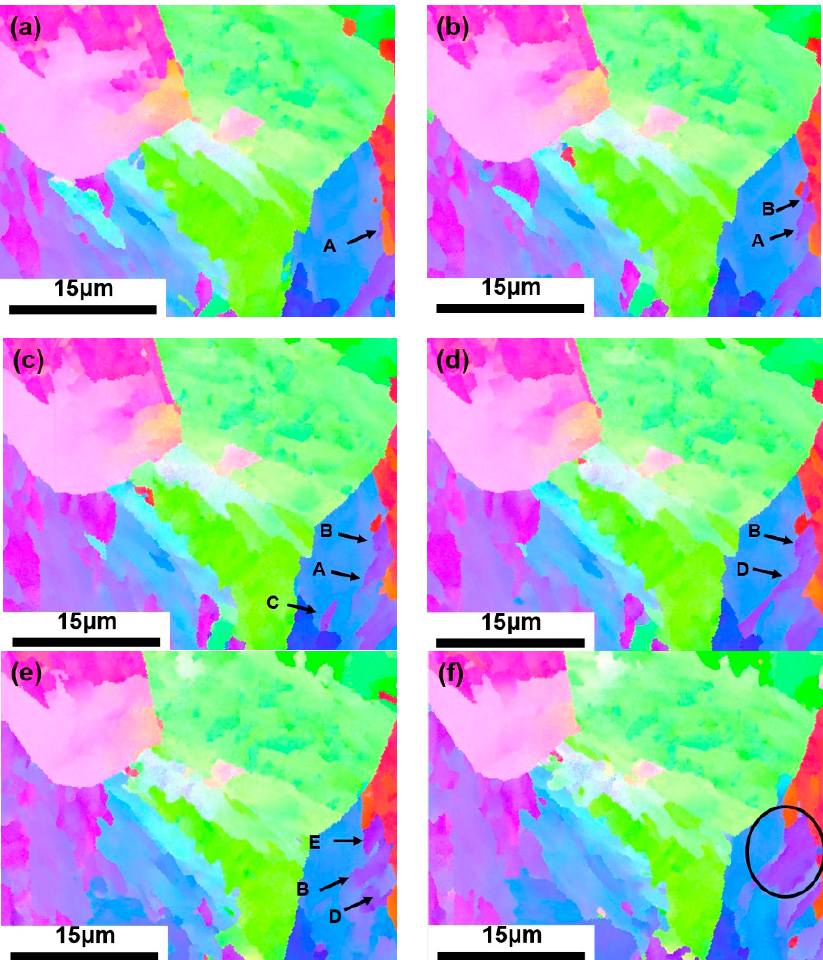
Figure 4. Grain orientation of primary Widmanstätten sideplates cutting process. ( a ) 110th layer, ( b ) 114th layer, ( c ) 117th layer, ( d ) 119th layer, ( e ) 127th layer, ( f ) 131st layer.